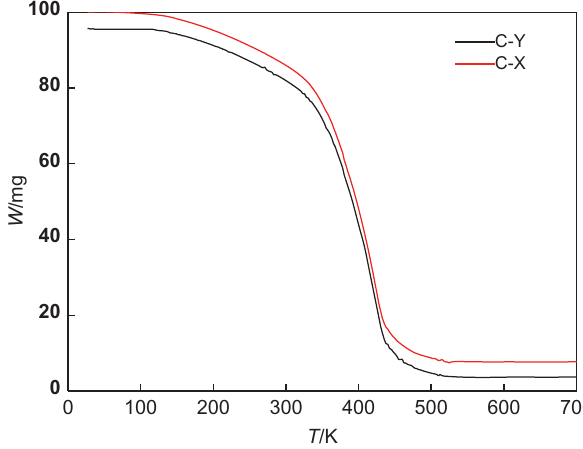
Figure 3: The thermal decomposition curves of two kinds of catalysts.